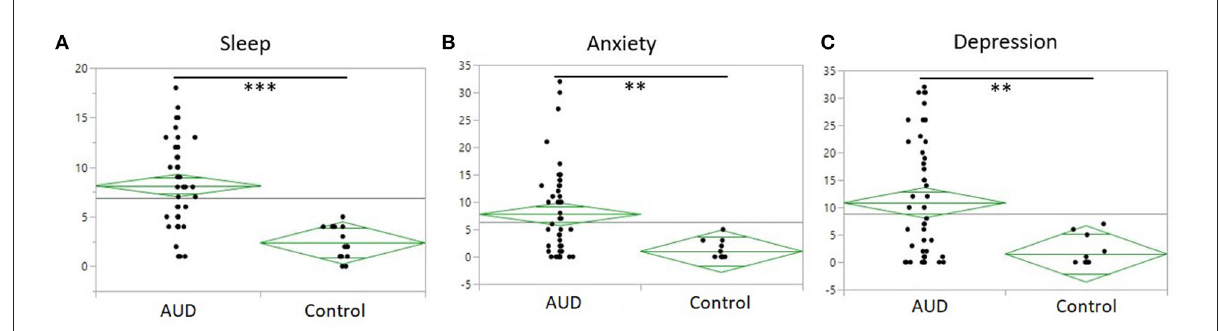
FIGURE2 One-way plot of AUD and controls of sleep, anxiety and depression. (A) PSQI (y-axis) between AUD group and controls (x-axis). Significant difference of PSQI between AUD group and controls ( P < 0.0001). Average PSQI in AUD group 8.14 to average PSQI in controls 2.35. (B) Anxiety measured by BSA (y-axis) between AUD group and controls (x-axis). Significant difference of anxiety in the AUD group ( P = 0.003). (C) Depression measured by MADRS (y-axis) between AUD group and controls (x-axis). Significant difference of depression scores in AUD group ( P =